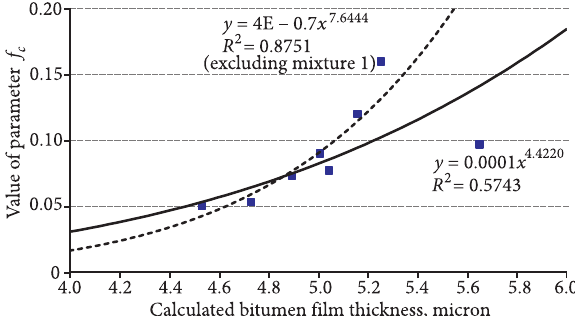
Fig. 8. Relation between theoretical bitumen film thickness and results of permanent deformation resistance of AC